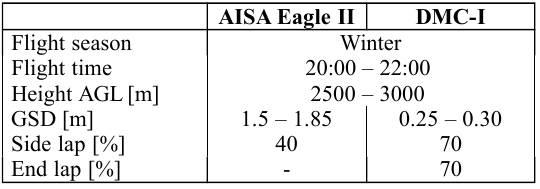
Table 2. Standard light pollution flight parameters